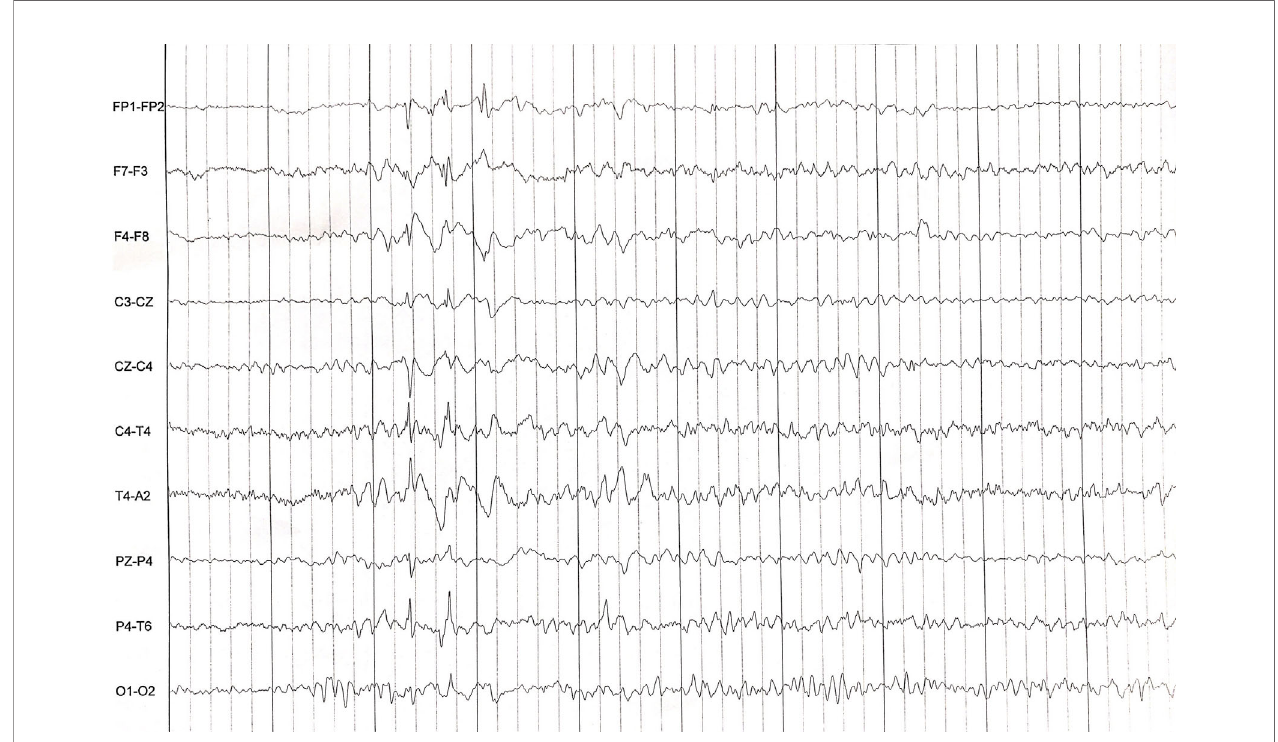
FIGURE 1 | EEG showing bilateral frontoparietal polyspikes and spike-and-wave discharges, predominantly on the right